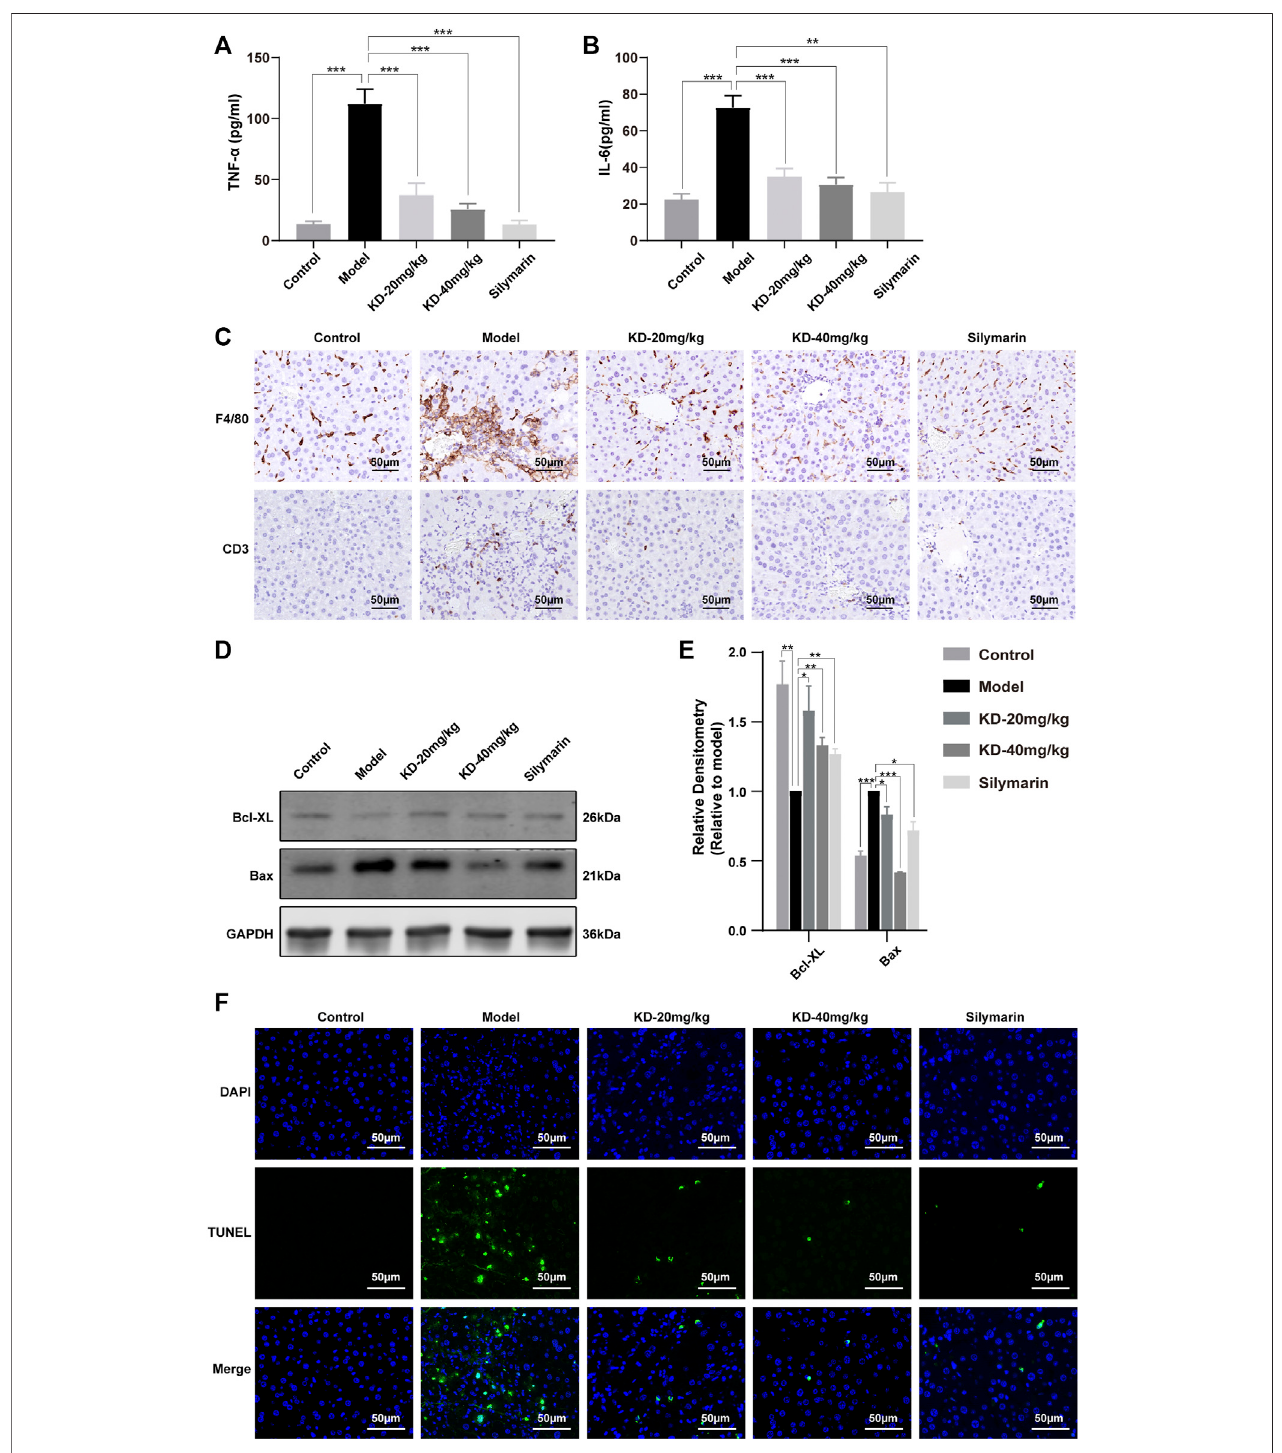
FIGURE 6 | Effects of KD on ethanol-induced liver in fl ammation and hepatocyte apoptosis in mice. (A) Serum TNF- α levels. (B) Serum IL-6 levels. ( n (cid:1) 5 – 7). (C) Immunohistochemistry staining for F4/80 and CD3 in the mice liver. (D) Expression of apoptosis-related proteins determined by western blotting. (E) Quantitative analysis of protein expression ( n (cid:1) 3). GAPDH was used as a loading control. (F) TUNEL-stained liver sections. Scale bar: 50 µm. Data represent the mean ± SEM. * p < 0.05, ** p < 0.01, *** p < 0.001 vs. the model group.